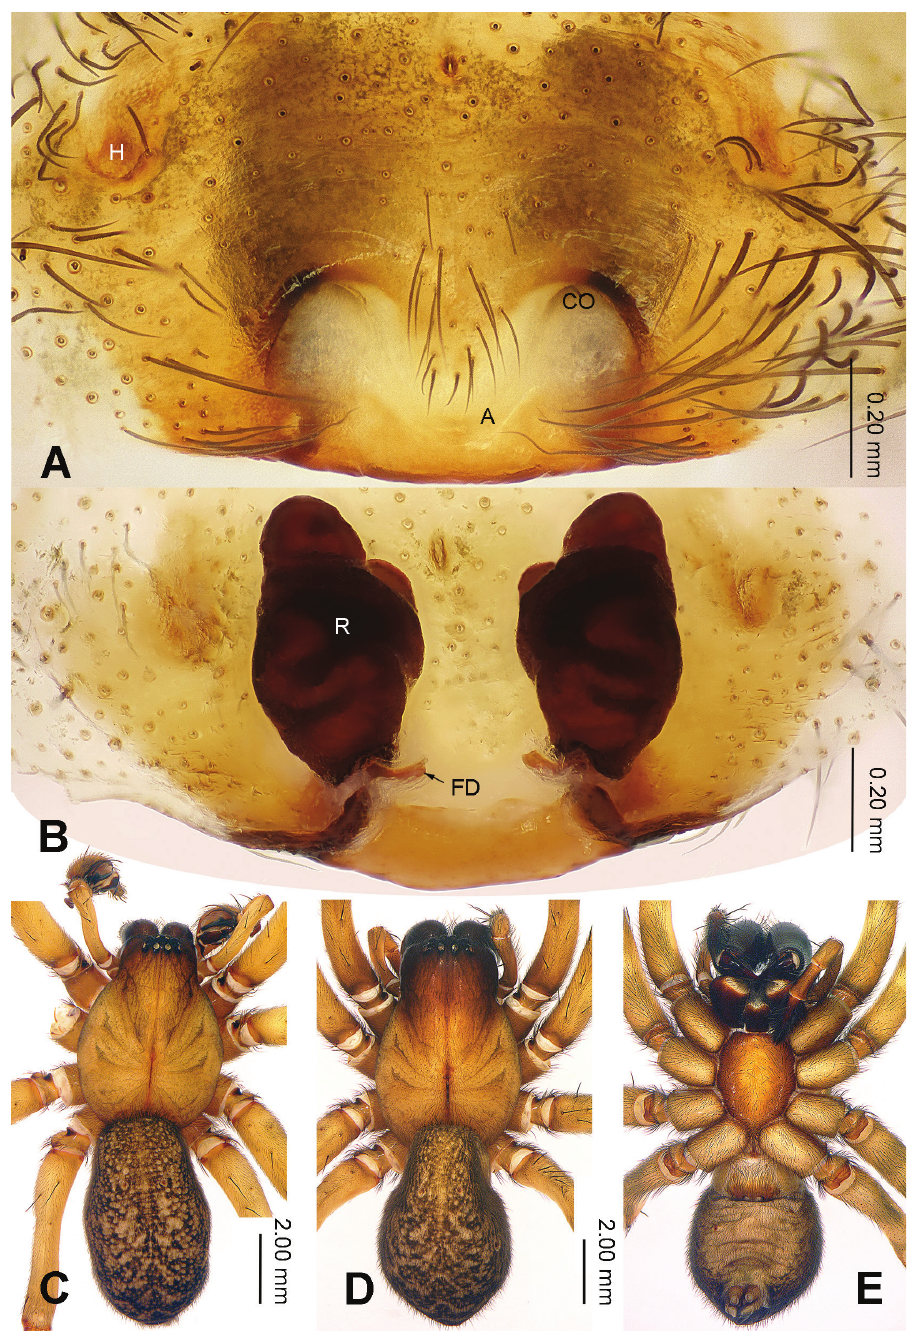
Figure 2. Epigyne and habitus of Sinodraconarius sangjiuensis sp. n. A Epigyne, ventral B Vulva, dorsal C Male habitus, dorsal D Female habitus, dorsal E Female habitus, ventral. Scale bar equal for D and E